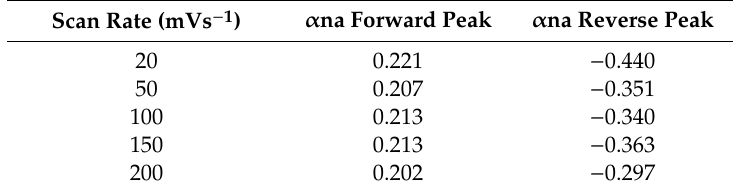
Table 2. Summary of α na values obtained at various scan rates for the anodic and cathodic peaks of vitamin